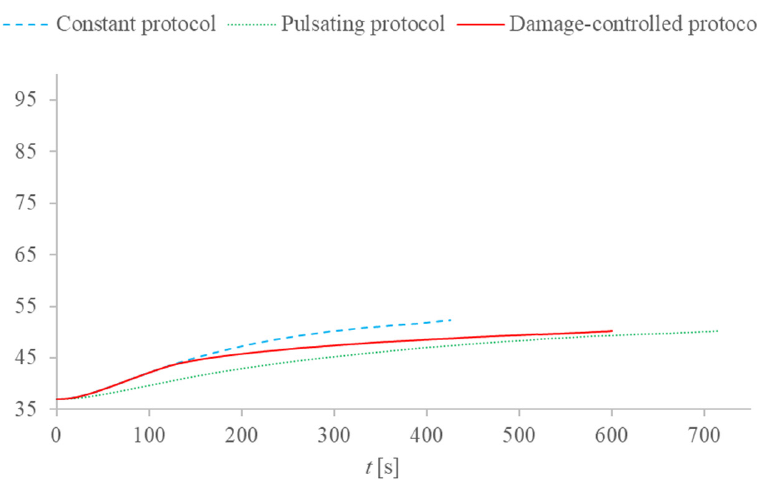
Figure 8. Tissue temperature evolution in time at target ablation point, ( r = 1.7 cm and z = 0.0 cm) for constant protocol, pulsating protocol, and damage-controlled protocol.